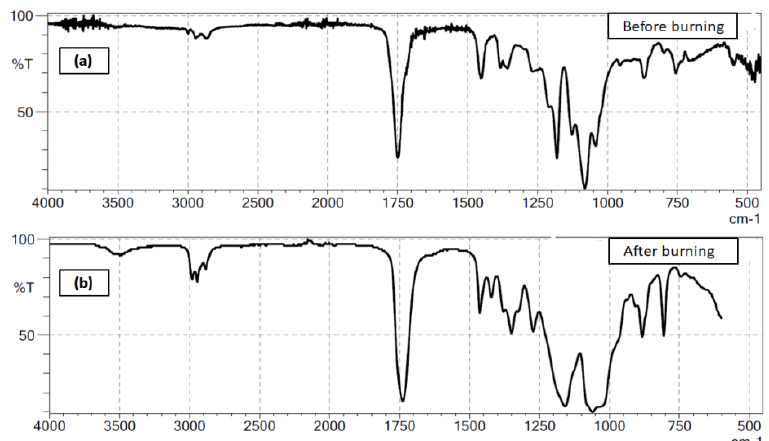
Figure 12. Fourier transform infrared (FTIR) spectra of PLA / OS7 / APP10 non-woven fabric ( a ) before burning ( b ) after burning